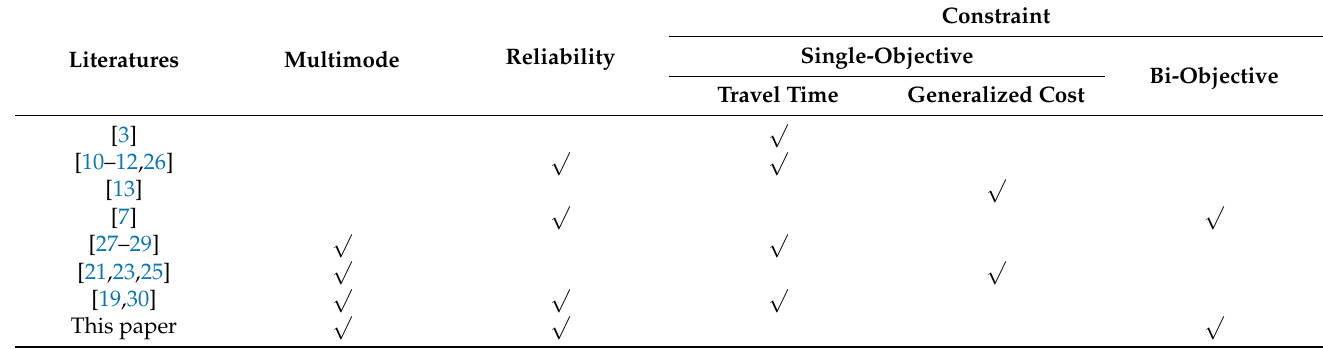
Table 1. Categories of existing